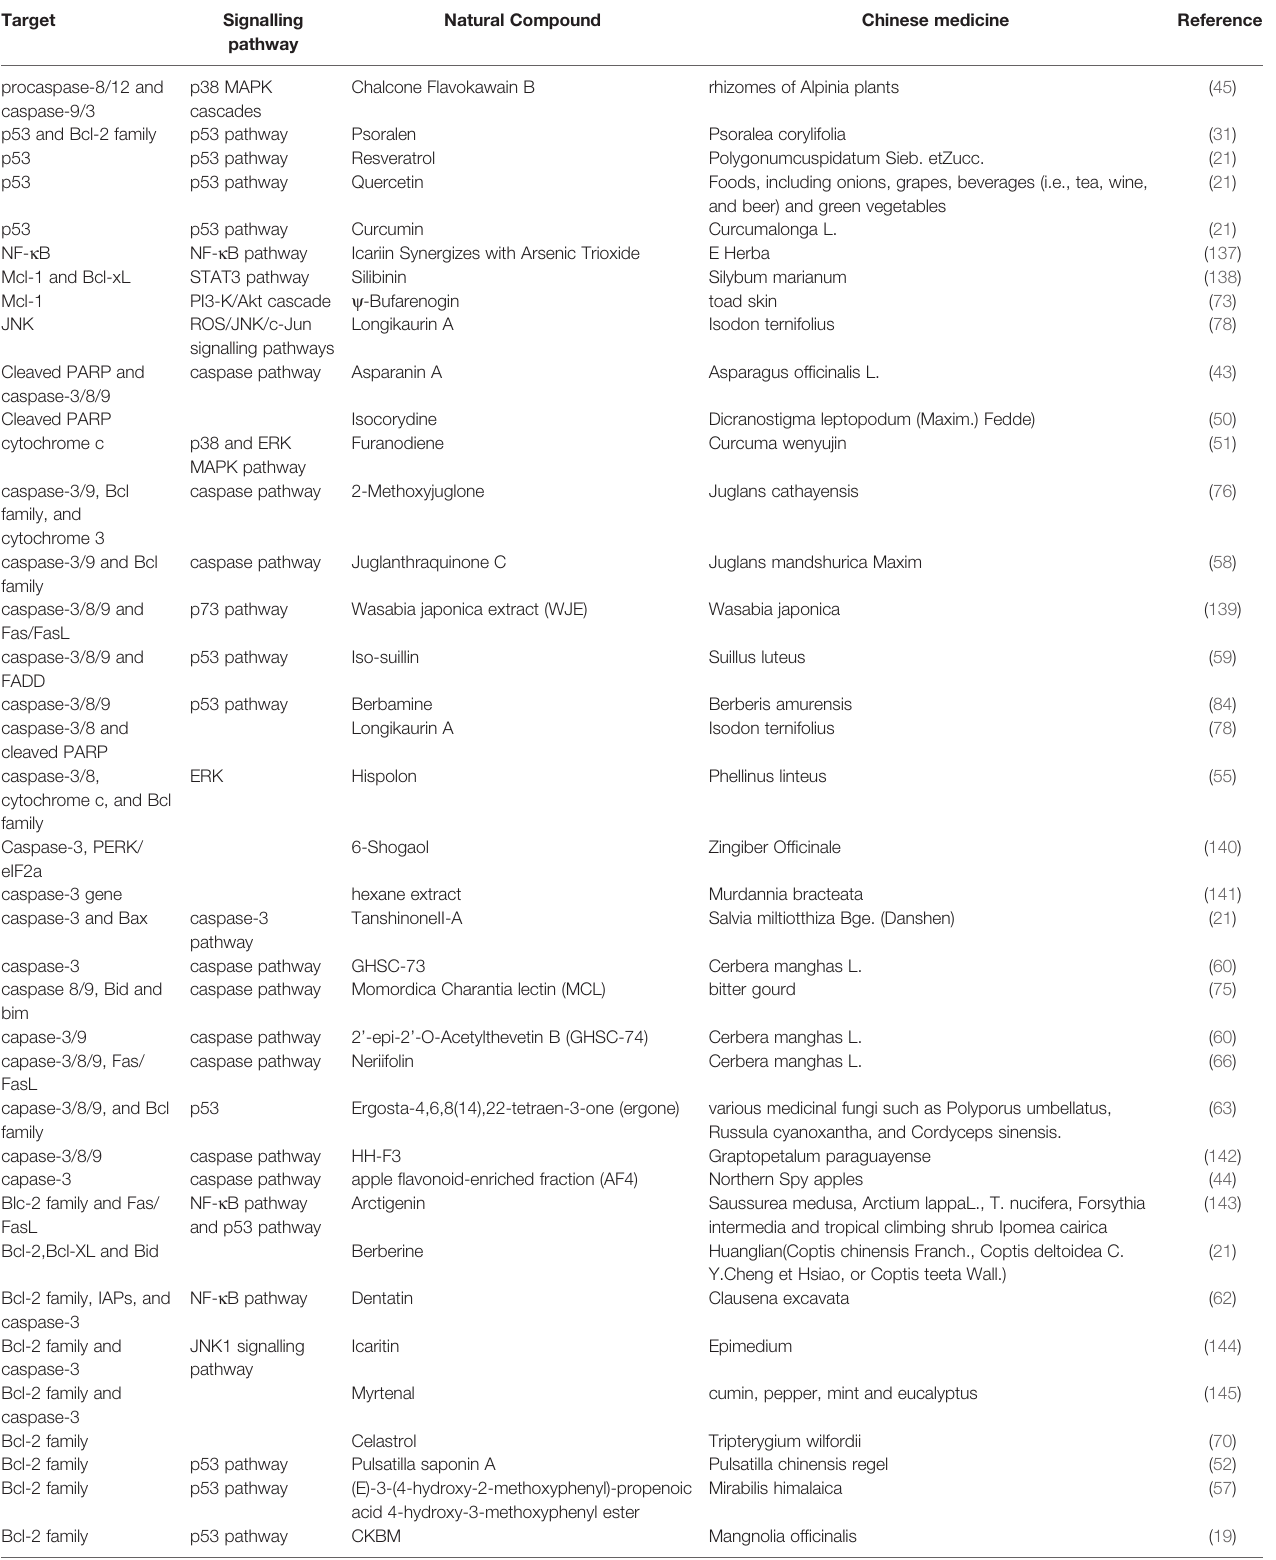
TABLE 2 | The targets and pathways of natural compounds in the process of inhibiting apoptosis in HCC.